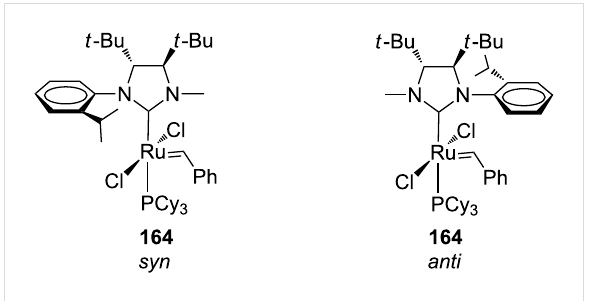
The catalytic performances of 164 were tested in the asym- metric ring-closing metathesis (ARCM) of prochiral trienes 166 , 168 and 170 (Scheme 15, Table 6) [52,54] achieving enan- tiomeric excesses (ee) that were generally lower with respect to those obtained with the C 2 -symmetrical analogue 165 [55] (Table